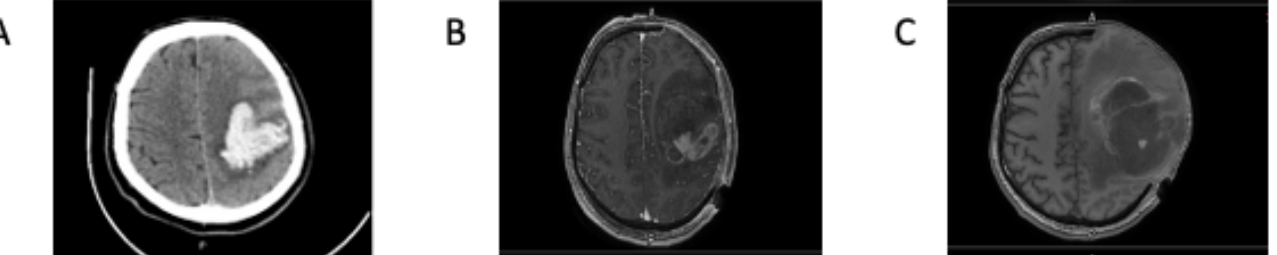
Figure 1. ( A ) MRI, performed in pre-surgery, showing a large, non-traumatic intraparenchymal hemorrhage with peripheral brain edema within the left temporo-parietal lobe. ( B ) MRI showing an intracranial mass after resolution of the hemorrhagic episode. ( C ) MRI showing a new hemorrhagic episode two months after surgical resection of the tumor. After the second neurosurgery, the patient received 10 cycles of external-beam radia- tion therapy (EBRT) at 3 Gray, but radiotherapy was interrupted after 9 cycles because of the poor performance status of the patient. After the last neurosurgery, the patient received chemotherapy based on doxorubicin and dacarbazine. The therapy was interrupted after two cycles because the patient died. The medical history of the patient is depicted in Figure